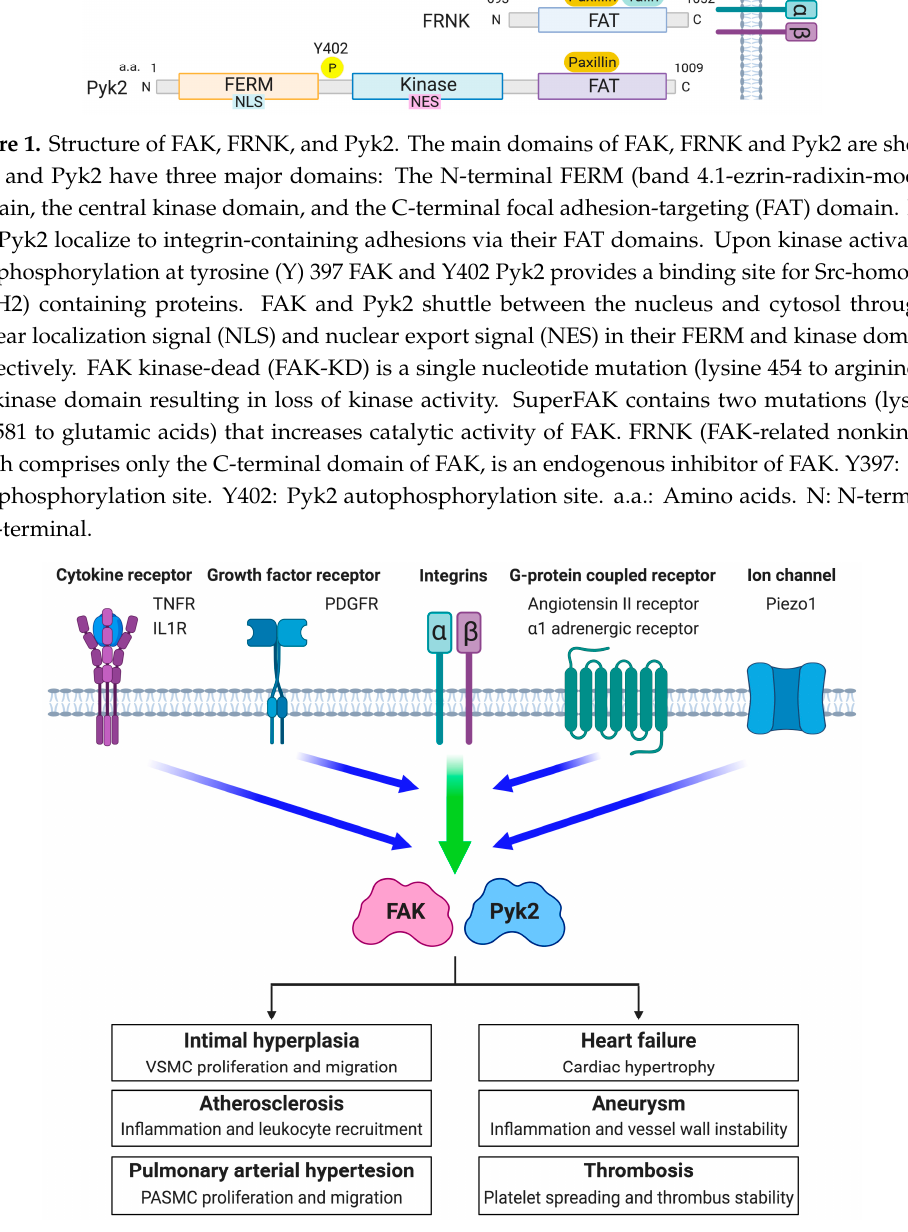
Figure 2. The potential roles of FAK and Pyk2 in vascular diseases. Integrins promote FAK and Pyk2 activation in cooperation with other cell surface proteins including cytokine receptors, growth factor receptors, G-protein coupled receptors, and ion channels. FAK and Pyk2 are major signaling mediators downstream of various signaling molecules during the initiation and continuation of intimal hyperplasia, atherosclerosis, pulmonary arterial hypertension, heart failure, aneurysm, and thrombosis. TNFR: tumor necrosis α receptor. IL1R: Interleukin-1 receptor. PDGFR: platelet-derived growth factor receptor. α -adrenergic receptor: phenylephrine receptor. Piezo1: mechanosensitive ion